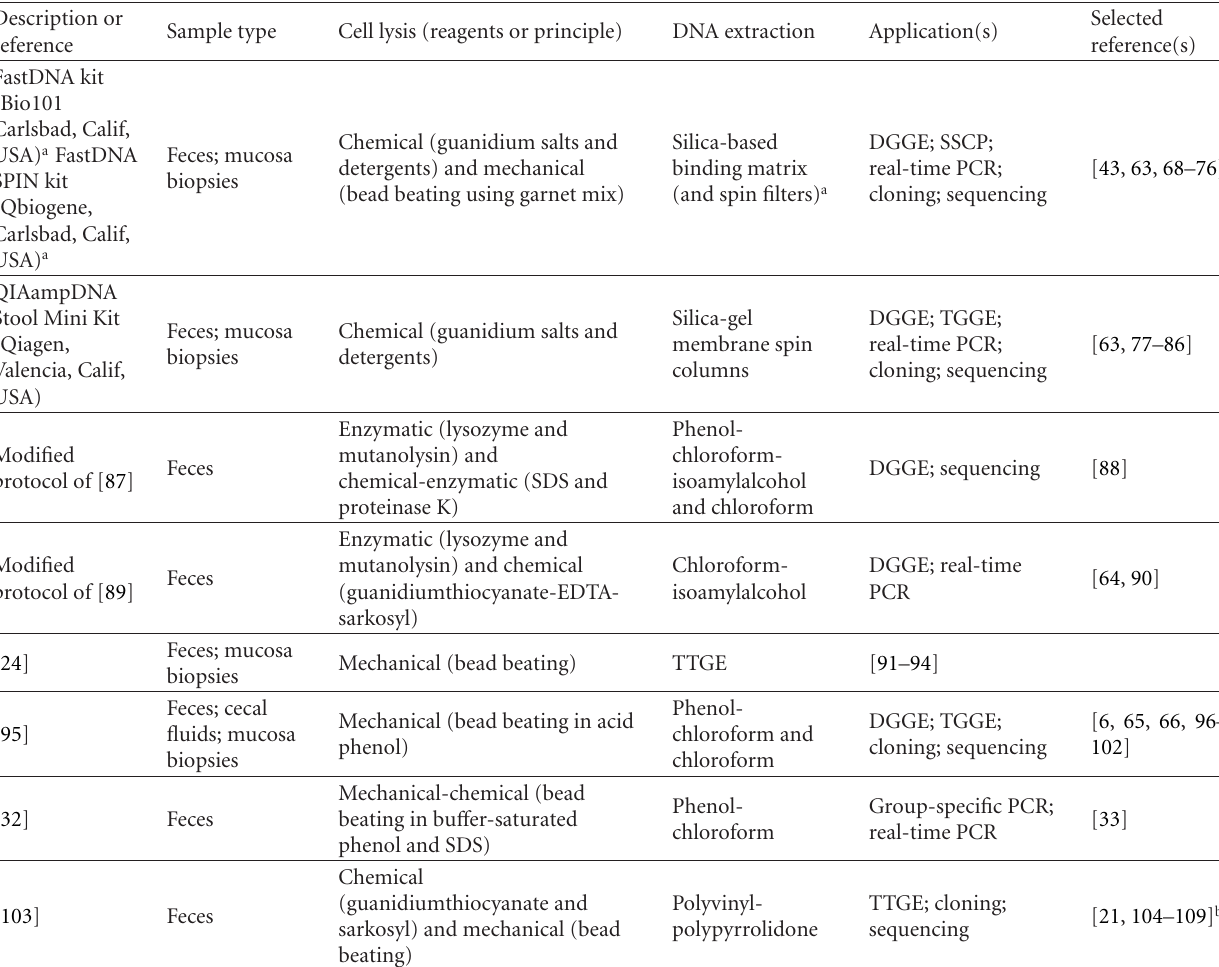
Table 1: DNA extraction procedures used in SDE-based profiling of human intestinal microbial